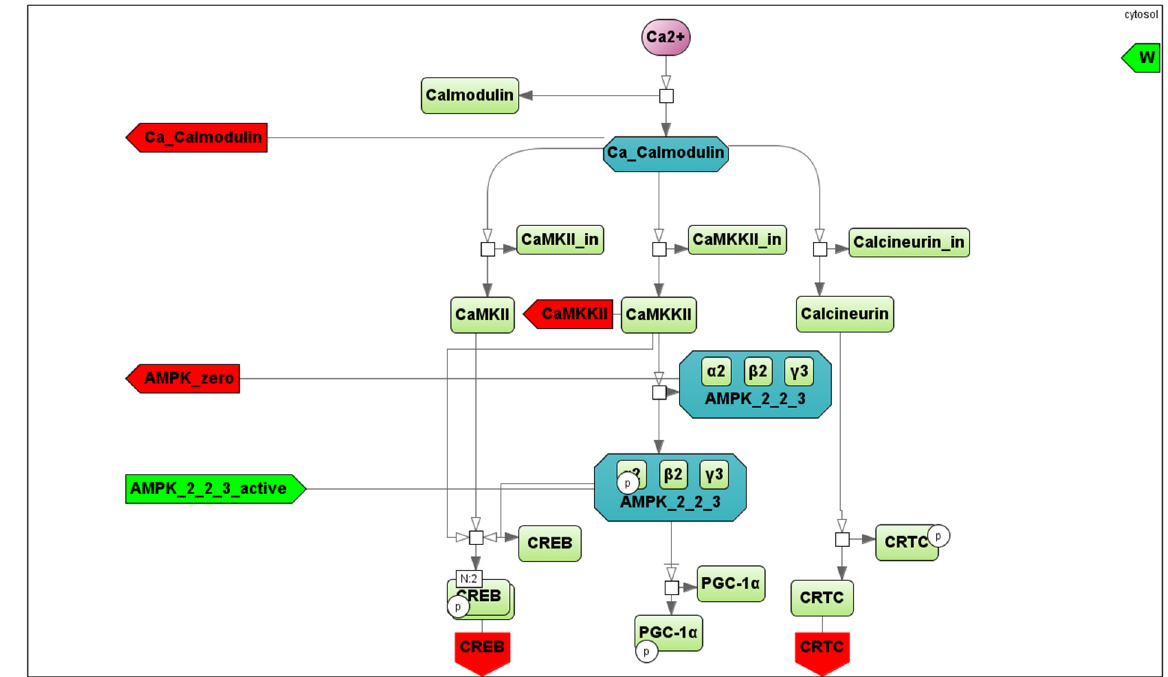
Figure 6. A general SBGN diagram of the modular model describing metabolism in human muscle fibers ( A ) taking into account metabolic processes in the cytoplasm ( B ) and the mitochondrion ( D ), and transport reactions between two com- partments ( C ) as well as modules of the Ca 2+ -dependent signaling pathway and AMPK activity considering different isoforms. Designations of input/output/contact ports are described above in the main text. The vertices of the bipartite graph in the Cytosol/Mitochondrion and Transport submodules correspond to the respective biochemical or transport reaction depending on the submodule. Each fiber type module also comprises submodules of Ca 2+ - and AMPK-dependent signaling pathways. All details for each submodule and zoomed-in subfigures are in the Supplementary Material.